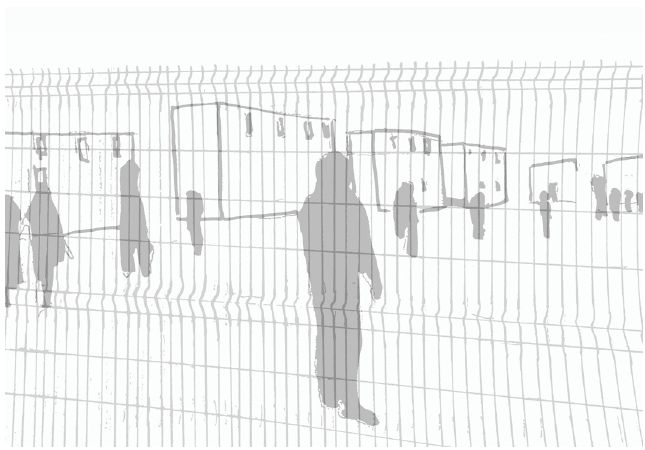
Figure 1 Melanye Garland, Field drawing, CAP containers, The Jungle, Calais,